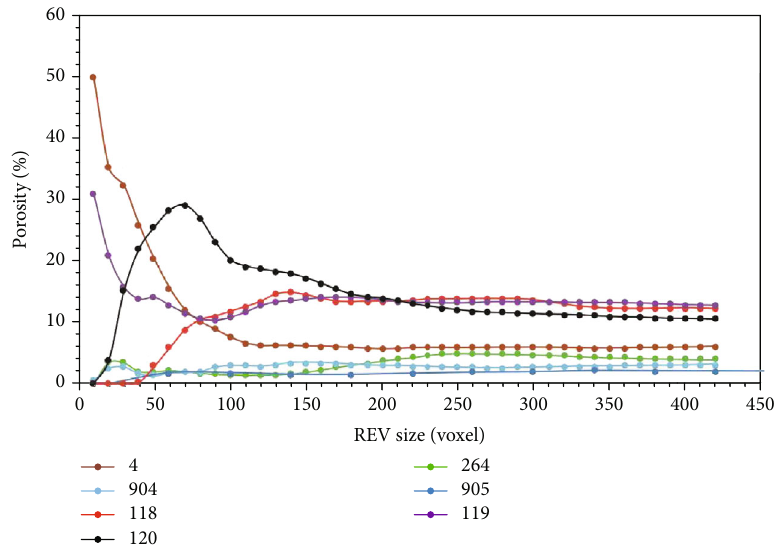
Figure 8: REV calculation with the coordinate from the top of the 3D reconstructions.